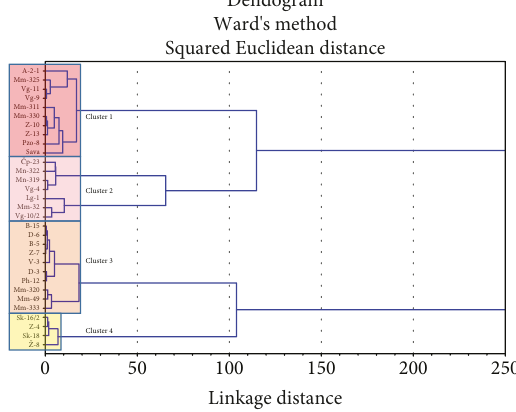
Figure 7: Results of the cluster